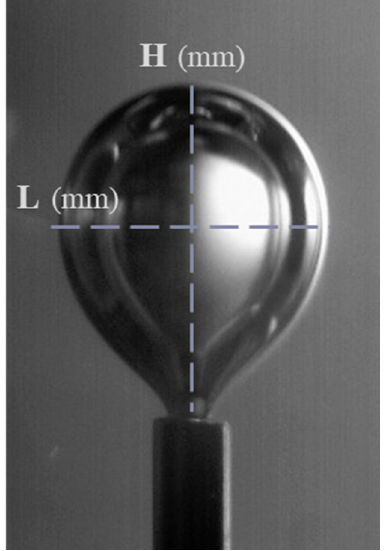
Figure 3. Major (H) and minor (L) axes of the ellipsoid.